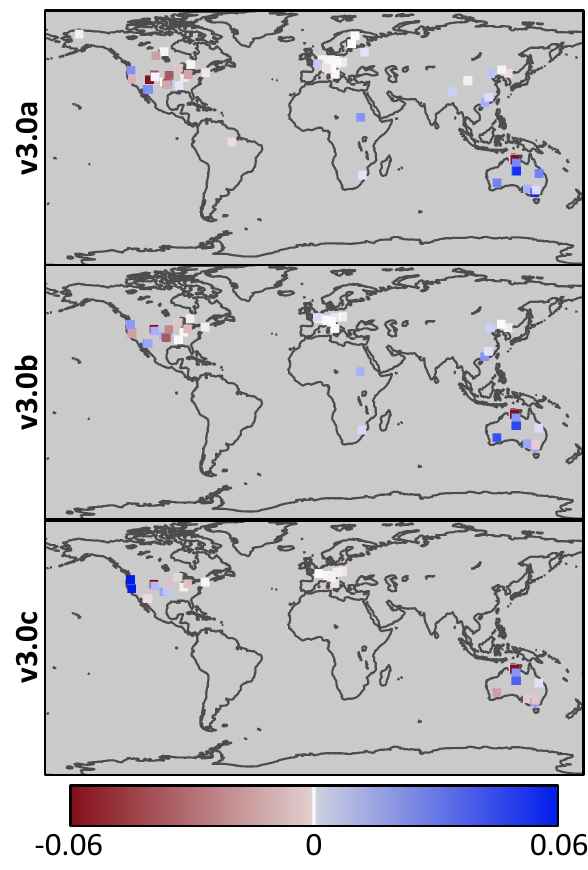
Figure 7. Difference in quality between the v3 and v2 data sets of terrestrial evaporation ( R( GLEAM v3 , in situ ) − R( GLEAM v2 , in situ ) ). Colours relate to the difference in corre- lations against in situ measurements for the v3 and v2 evaporation data sets. Statistics are calculated based on all available sites report- ing measurements falling within the spatio-temporal domain of the different data